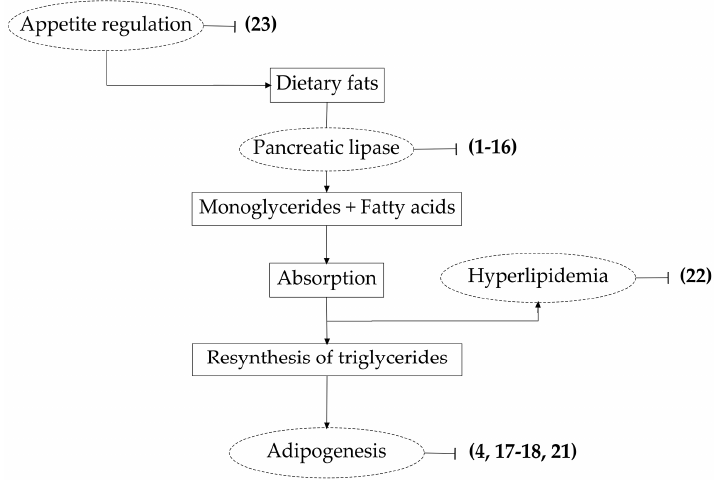
Figure 1. Schematic representation of the modes of action of saponins on lipid metabolism. Numbers between the brackets represent the molecules reported in Figures 2–5 and 7.